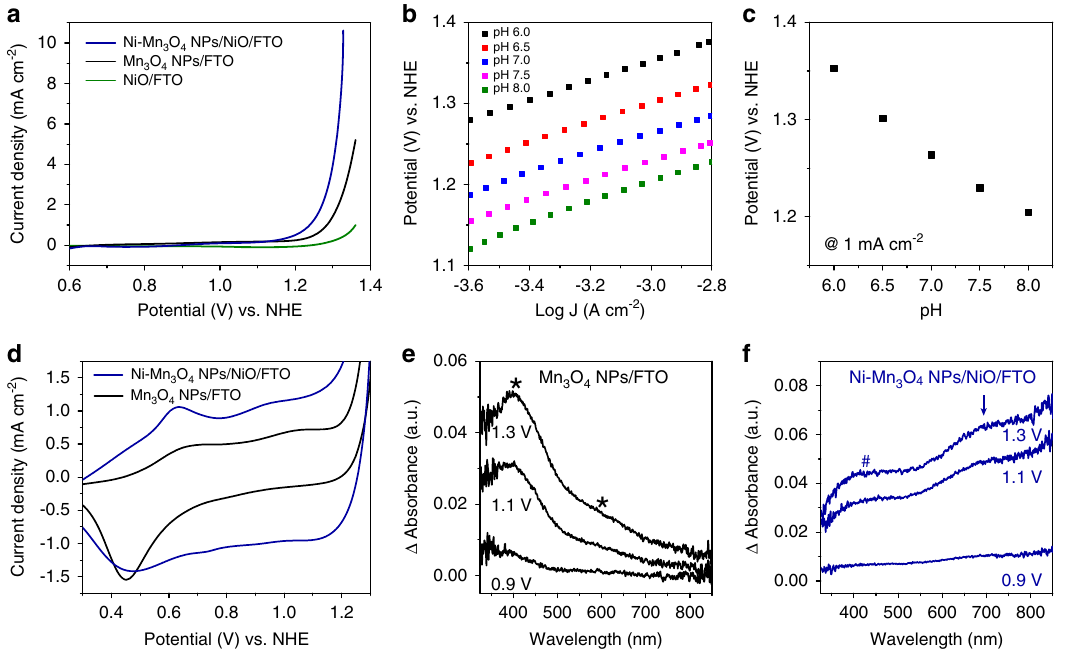
Fig. 2 Electrochemical kinetic analysis and in-situ UV-Vis spectroscopic analysis. a Polarization-corrected CV curves for NiO, Mn 3 O 4 NPs, and Ni – Mn 3 O 4 NPs/NiO in 500 mM phosphate buffer (pH 7). b Tafel plot of Ni – Mn 3 O 4 NPs/NiO at various pH. c pH dependency of Ni – Mn 3 O 4 NPs/NiO under neutral conditions. d CV curves for Ni – Mn 3 O 4 NPs/NiO and Mn 3 O 4 NPs in 500 mM phosphate buffer (pH 7). Two distinct oxidation peaks were observed at ~0.6 and 1.0 V. According to a previous study, the fi rst wave is attributable to the transition from Mn(II)-H 2 O to Mn(III)-OH. e , f In-situ UV-Vis